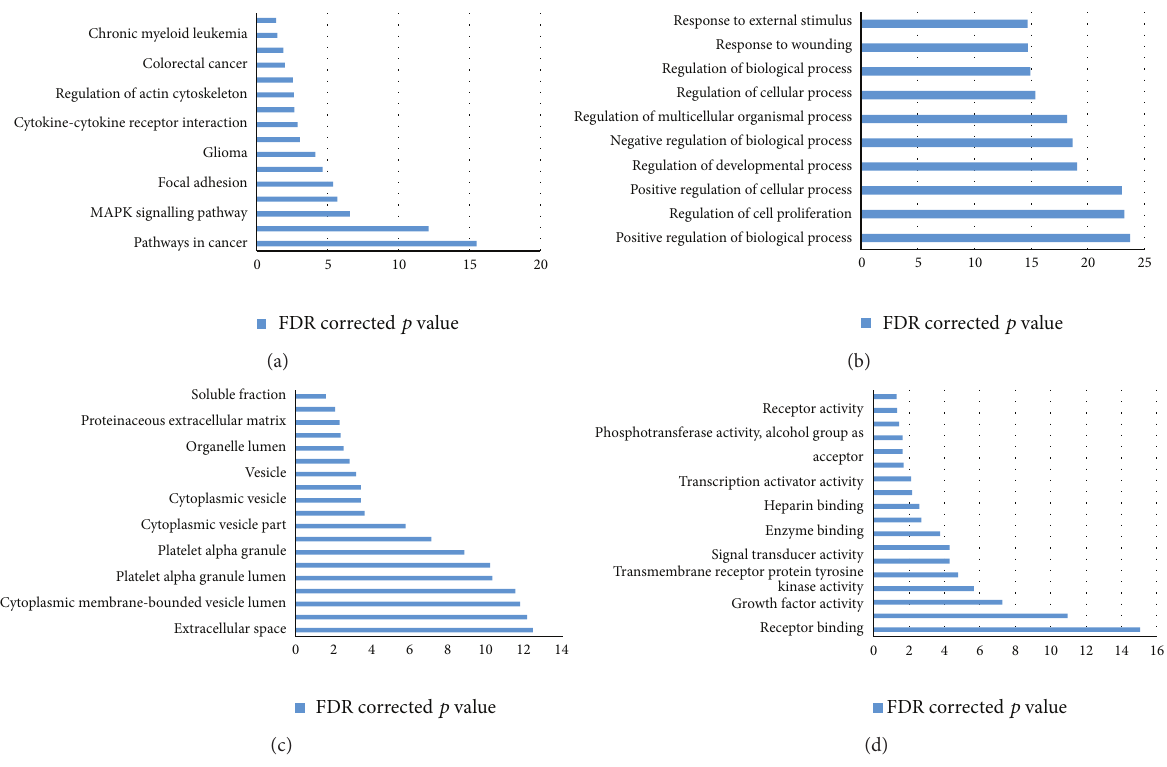
Figure 5: (a) Most enriched KEGG pathways from DAVID analysis. (b) Enriched biological processes. (c) Enriched cellular components. (d) Enriched molecular